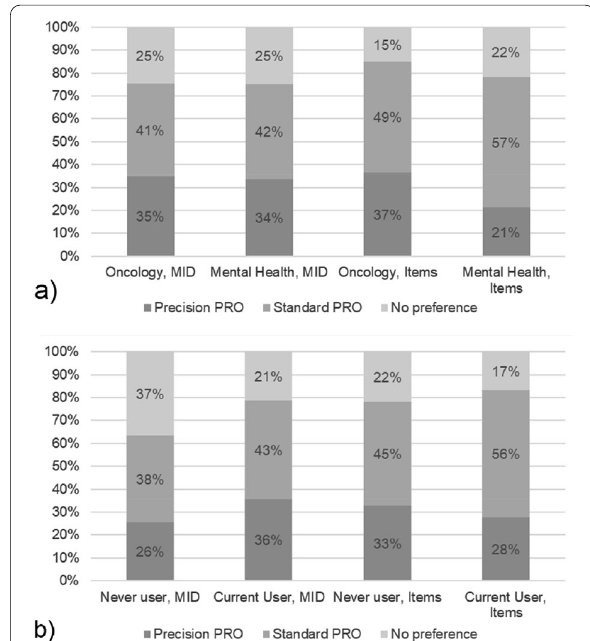
Fig. 2 Preferences between individualized (precision) and standard PROs by provider type ( a ) and user type ( b ). The ‘no preference’ category included people who preferred both types, neither type or chose not to answer. Items refers to approach for choosing items. MID minimally important difference and refers to approach for = defining